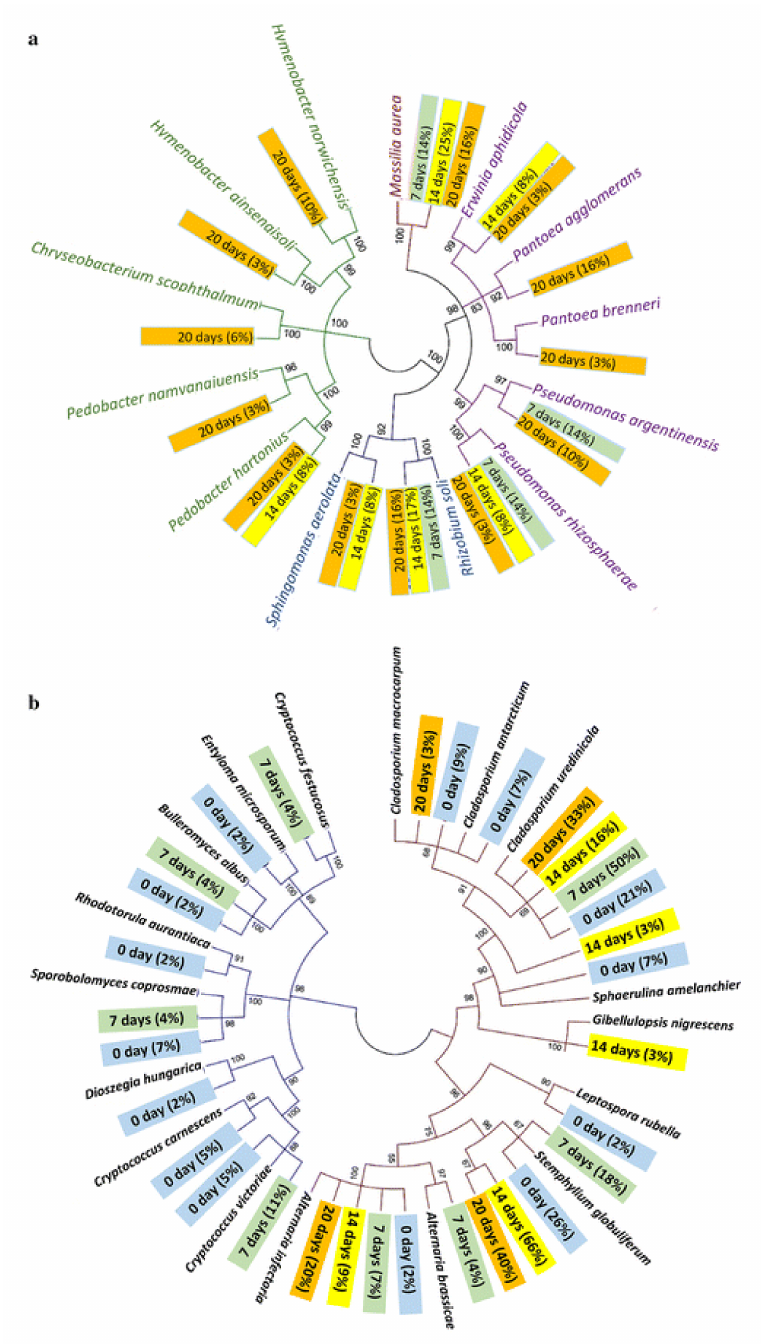
Figure 3. The phylogenetic tree of the ( a ) bacterial and ( b ) fungus communities found in hemp fibre samples. The color of the branches indicates the type of proteobacteria present, while the color of the tag indicates the number of bacteria/fungi present on different days